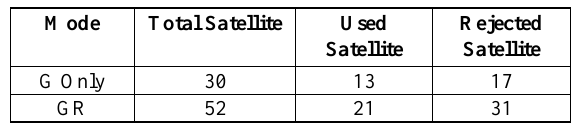
Figure 6: Different DOP values for combined GR observation processed by gLAB software